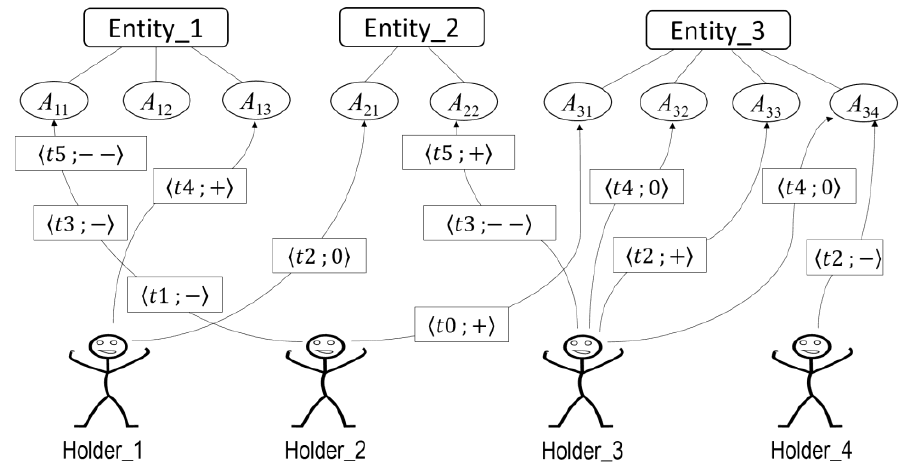
Fig. 1. An intuitive explanation of essential opinion